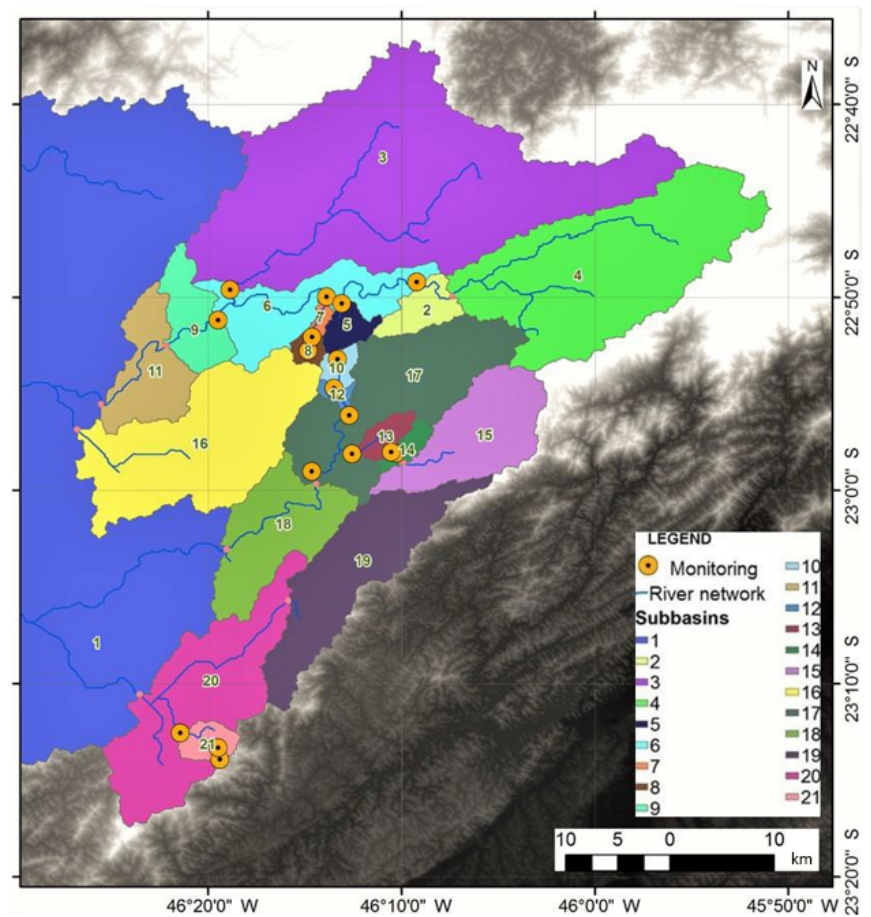
Figure 8. Study area divided into sub-basins for hypothesis testing using semi-distributed SWAT model.